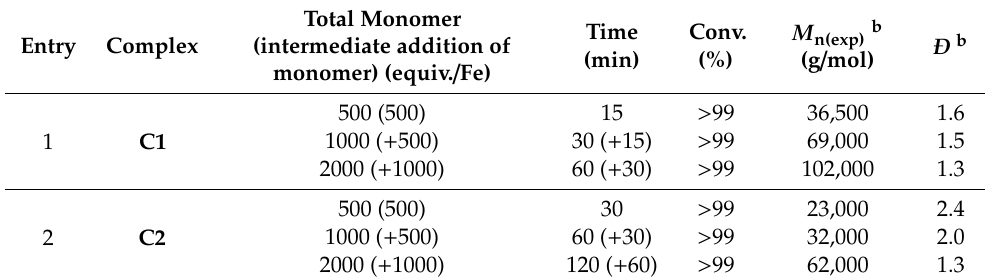
Table 3. Sequential polymerization of isoprene using C1, C2 / Al i Bu 3 / [Ph 3 C][B(C 6 F 5 ) 4 ] catalytic systems a